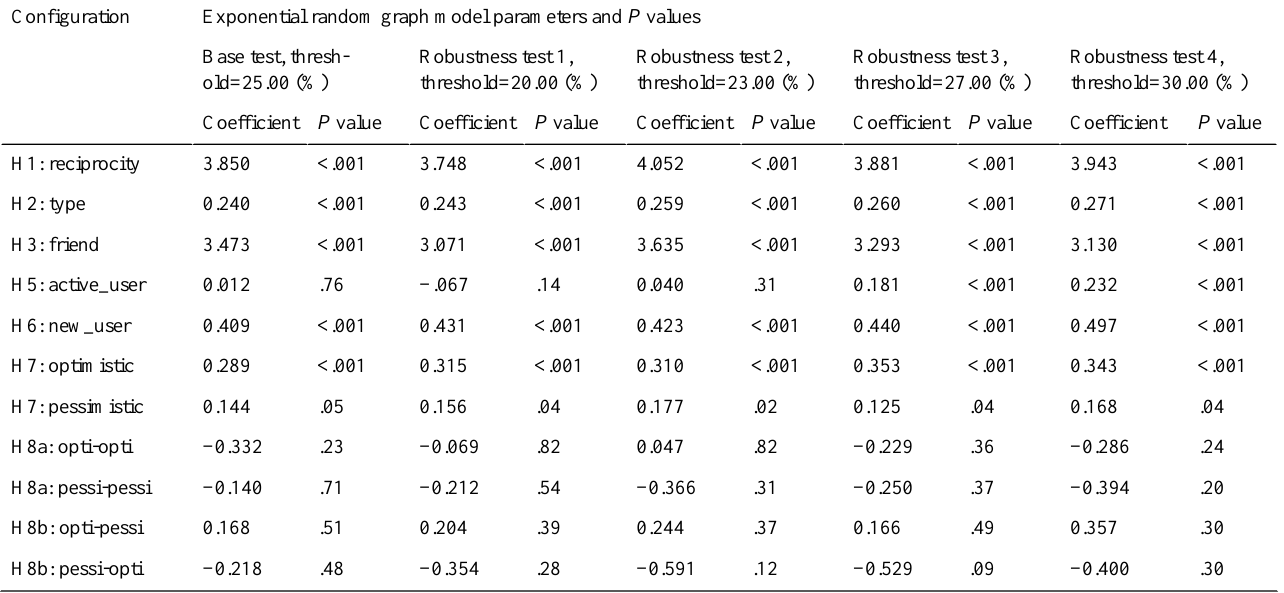
Table 4. Results of robustness tests, active users evaluated under different thresholds. Exponential random graph model parameters and P